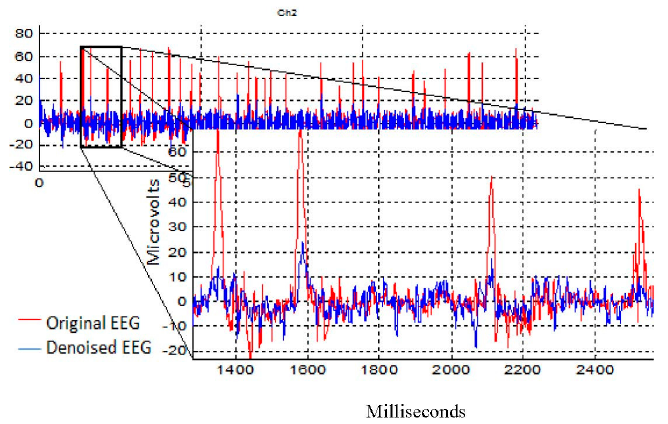
Figure 11. The removal results after the AICA–WT technique was applied on the EEG Ch2 which represents F8 to remove OA.